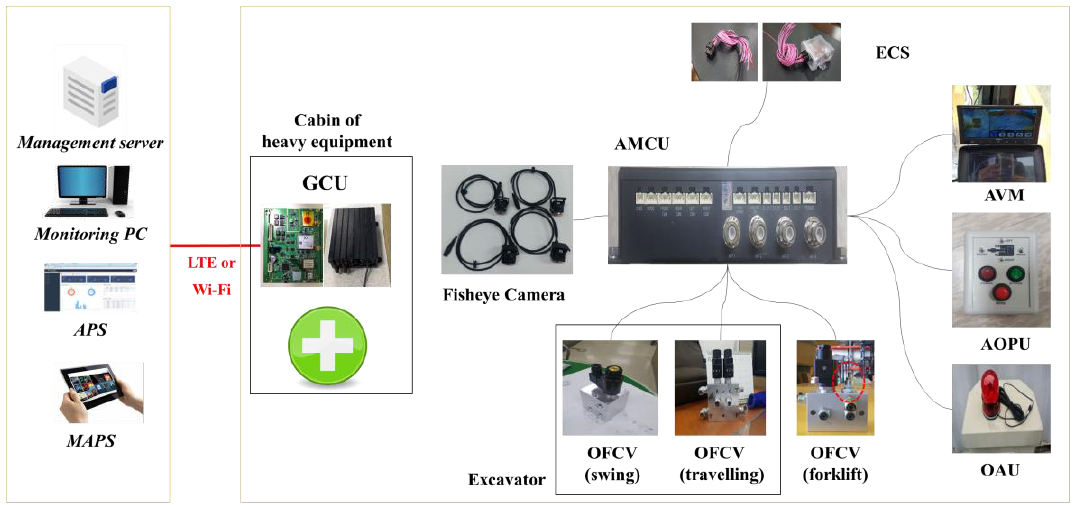
Figure 9. Operational scenario of ACAS and GRMS.